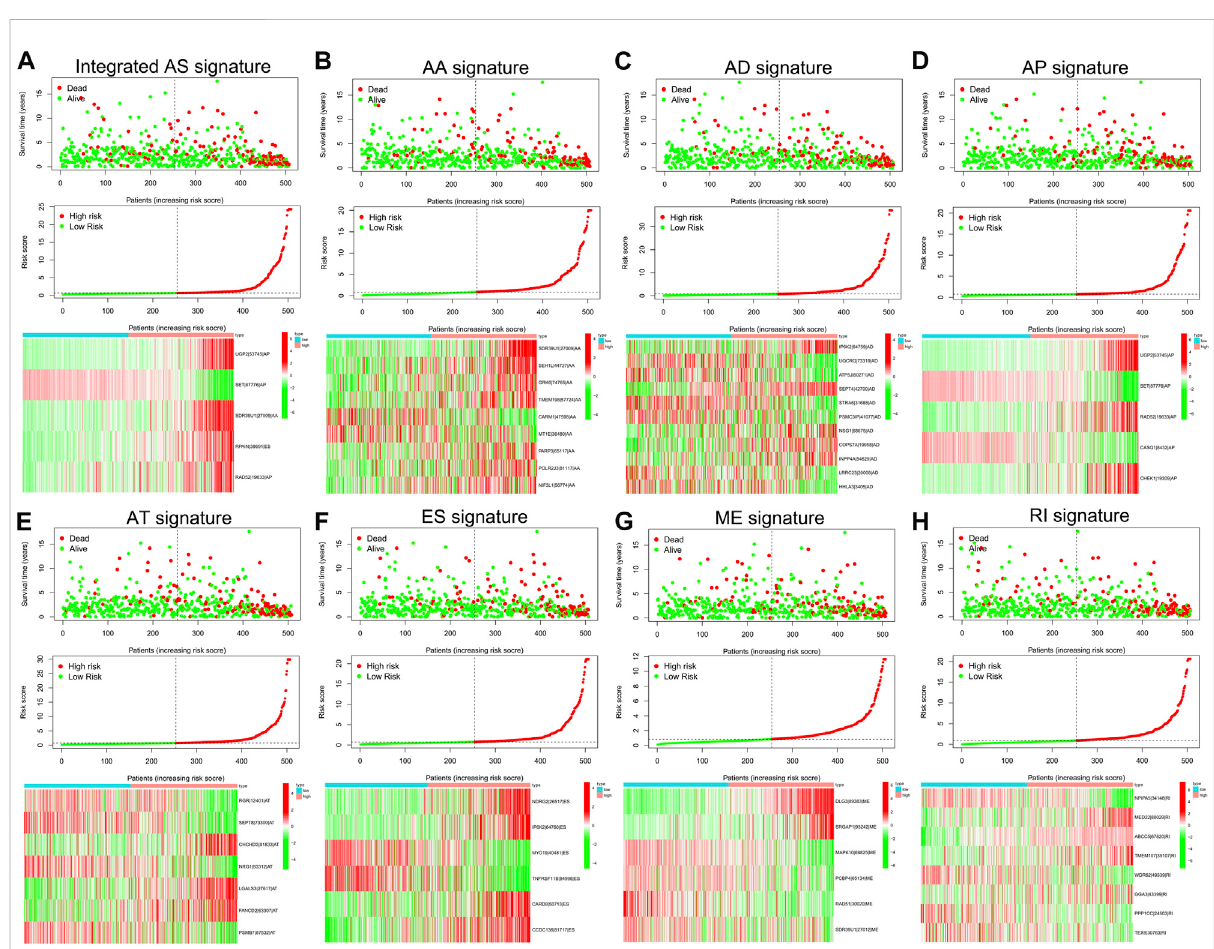
FIGURE 6 (A – H) . The risk scores associated with seven different kinds of m6A methylation regulator-associated AS signatures and combined AS signatures in patients with LGG. The spread of overall survival for patients with different risk scores is shown in the top panel of the fi gure. The variance trend in patient survival time with risk scores is shown in the center panel. The heatmap of AS events associated with the survival-related m6A methylation modulator is shown in the lower